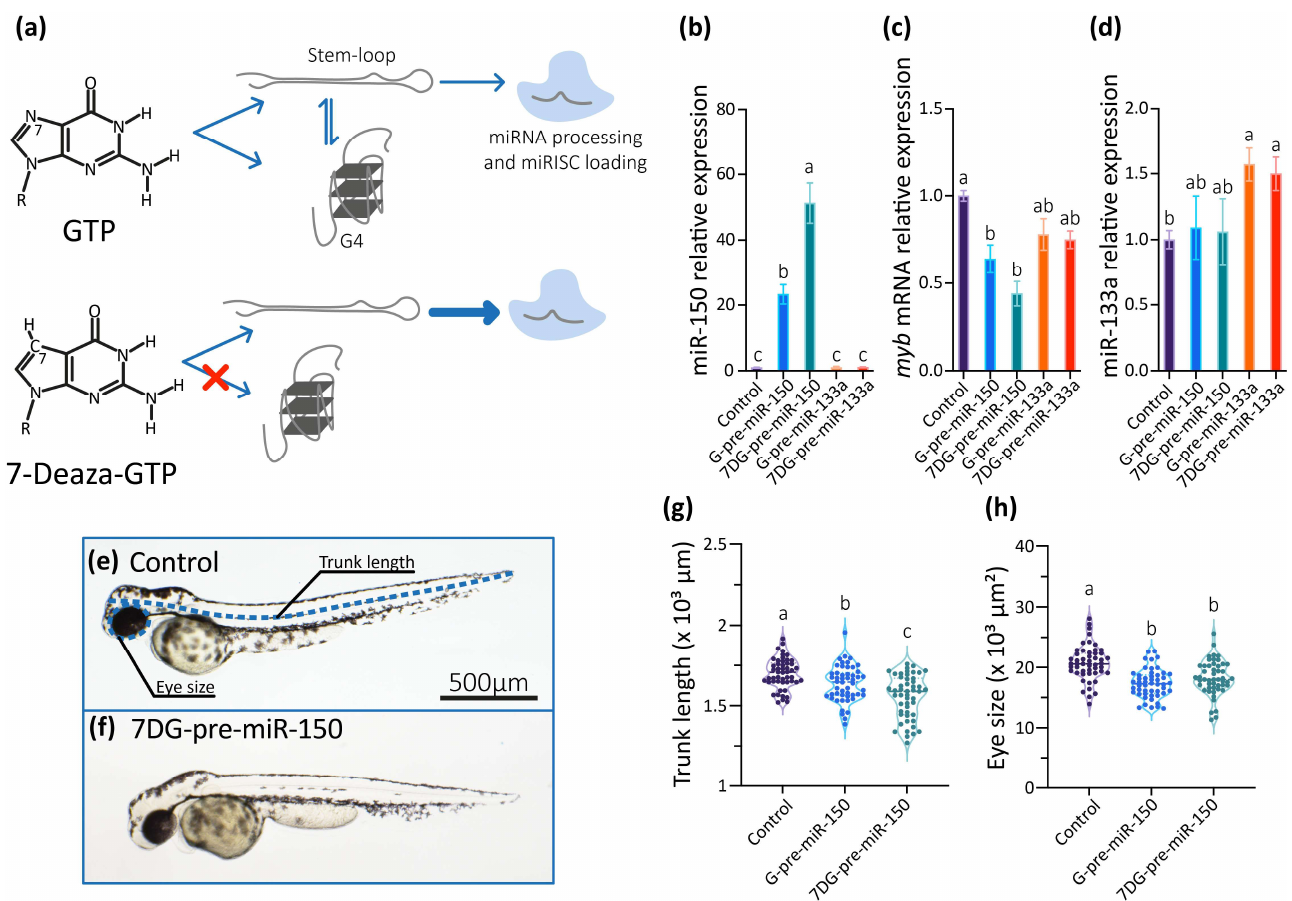
Figure 3. In vivo analysis of the role of the G4 present in pre-miR-150 during zebrafish embryo development. ( a ) Diagram of the strategy used to disrupt the formation of the G4 in the pre-miR-150 microinjected in zebrafish embryos. Reverse transcription followed by quantitative PCR (RT-qPCR) of miR-150 ( b ), myb ( c ), and miR-133a ( d ) using RNA samples from 24 hpf staged embryos microinjected with miR-150 or miR-133a precursors synthesized using either GTP (G-pre-miR-150 and G-pre-miR-133a) or 7-Deaza-GTP (7DG-pre-miR-150 and 7DG-pre-miR-133a). Ordinary 1-way ANOVA with Tukey multiple comparisons test, p < 0.005. Micrographs of representative 48 hpf staged larvae (lateral view, head to the left) microinjected with the RNA transcribed from pSP64T+dsRED plasmid containing no cloned pre-miRNA (control , ( e )) and 7DG-pre-miR-150 ( f ), with the measured parameters indicated by blue, dashed lines in ( e ). Trunk length ( g ) and eye size ( h ) measurements of 48 hpf staged larvae microinjected with G-pre-miR-150 or 7DG-pre-miR-150. Ordinary 1-way ANOVA with Tukey multiple comparisons test, p < 0.001. Letters above each condition in the graphs represent statistical groups, where means with no letter in common are significantly different. For graphs shown in ( b – d , g , h ) p -values are detailed in Supplementary Table S7 and numerical values are detailed in Supplementary Table S8. Data shown represent results of one from three independent experiments.